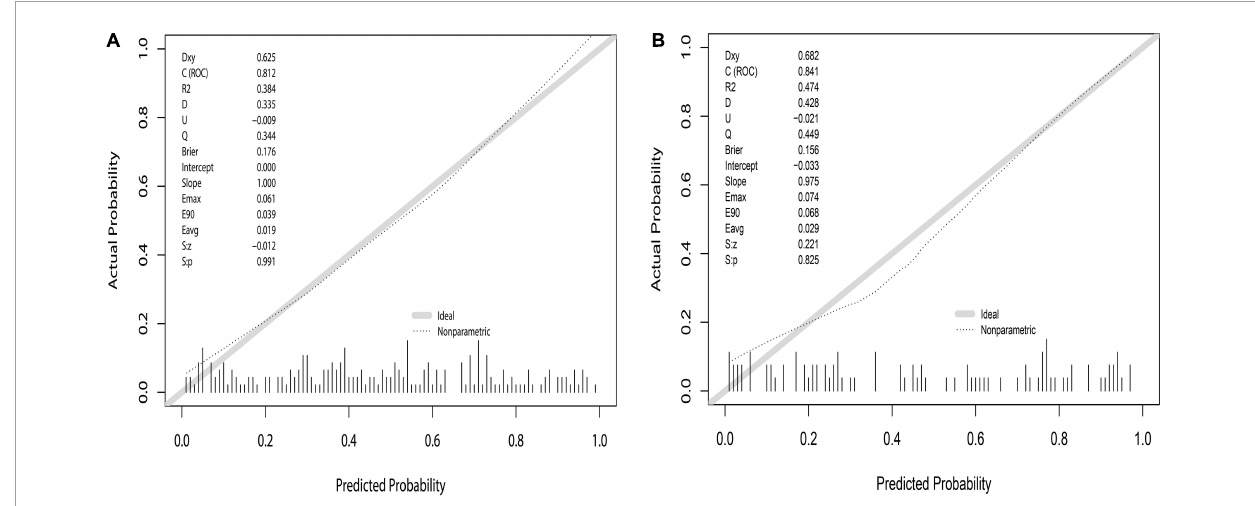
FIGURE6 Nomogram calibration curve to predict the risk of PVST in HLD patients in the development (A) and validation (B) sets. The calibrations of development and validation sets are verified based on Hosmer–Lemeshow goodness-of-fit test, where X -axis represents the probability of nomogram prediction of PVST, and Y -axis represents the actual incidence of PVST.